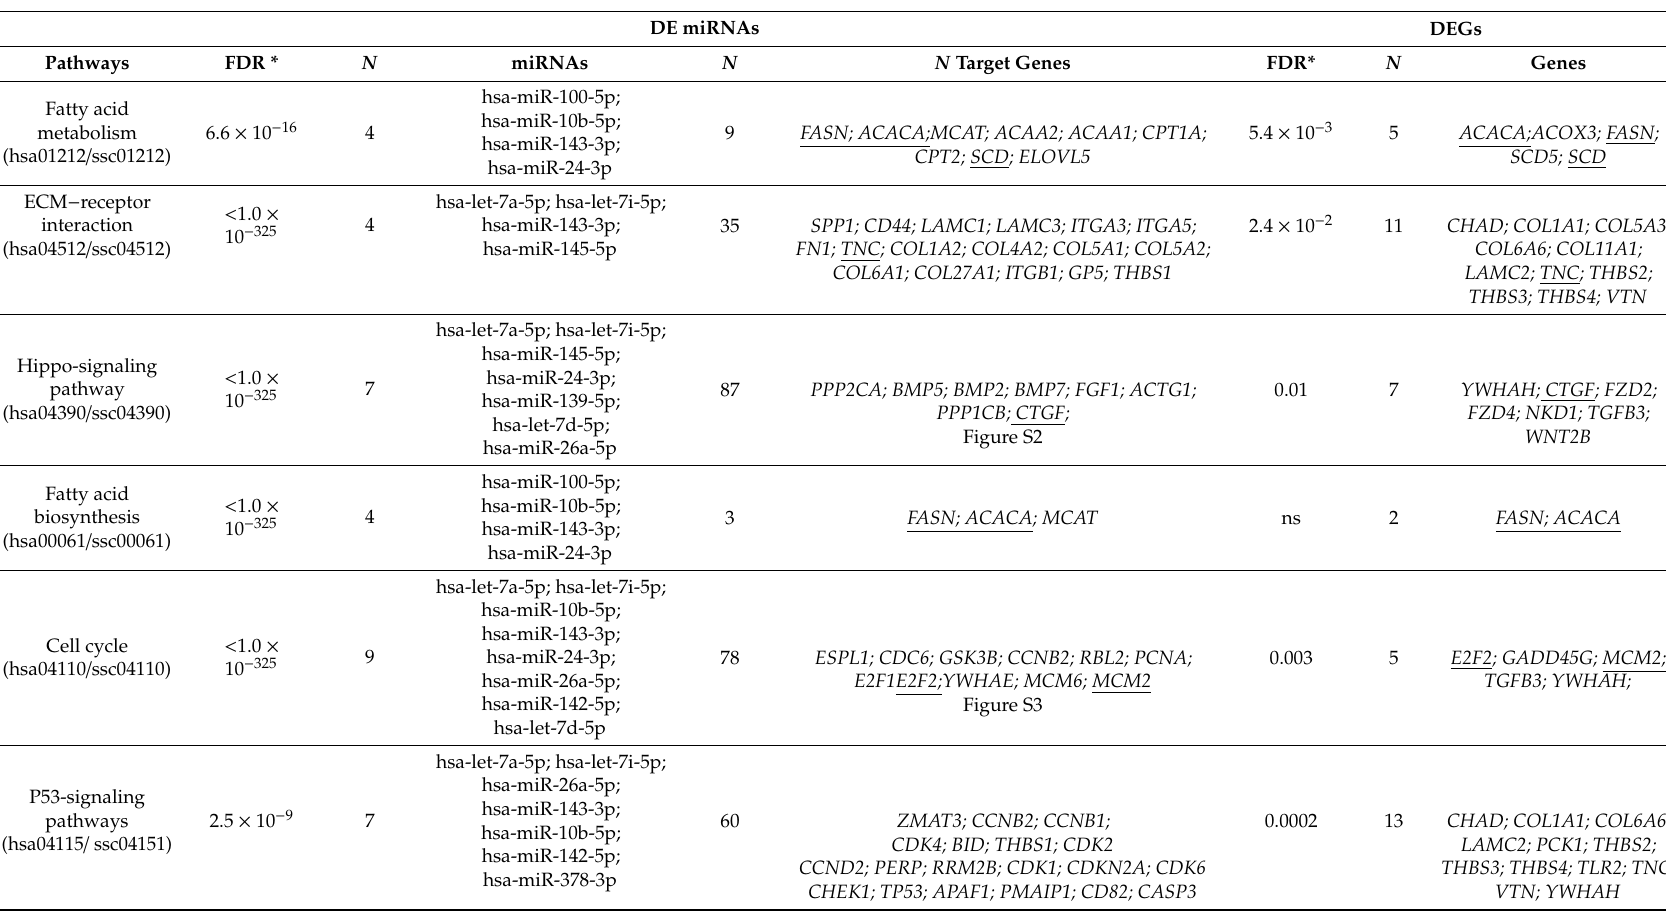
Table 5. Significant pathways detected for both DEGs (significant for at least two breeds) and DE miRNAs (14 miRNAs common for all breeds). DE